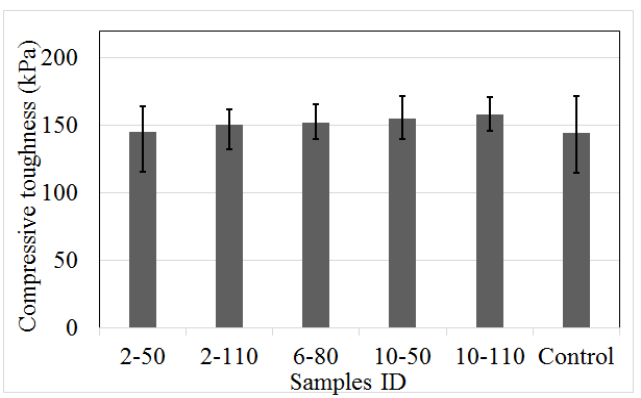
Figure 9. Compressive toughness of control samples and concrete with recycled PET fibres.